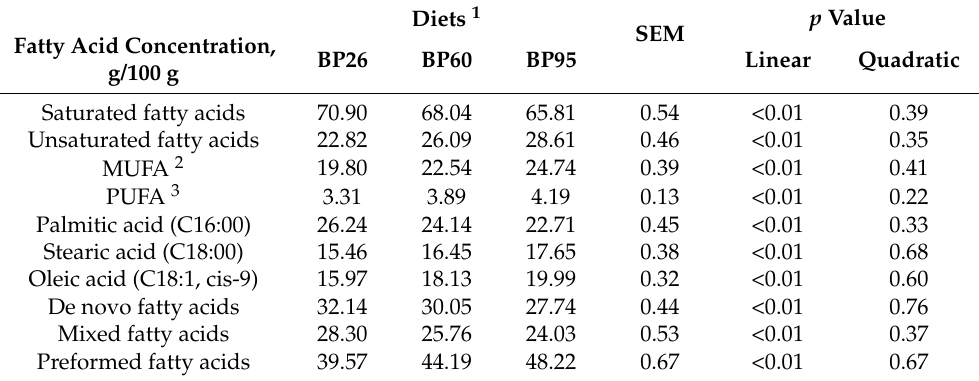
Effect of replacing human-edible feed ingredients with byproducts on milk fatty acid